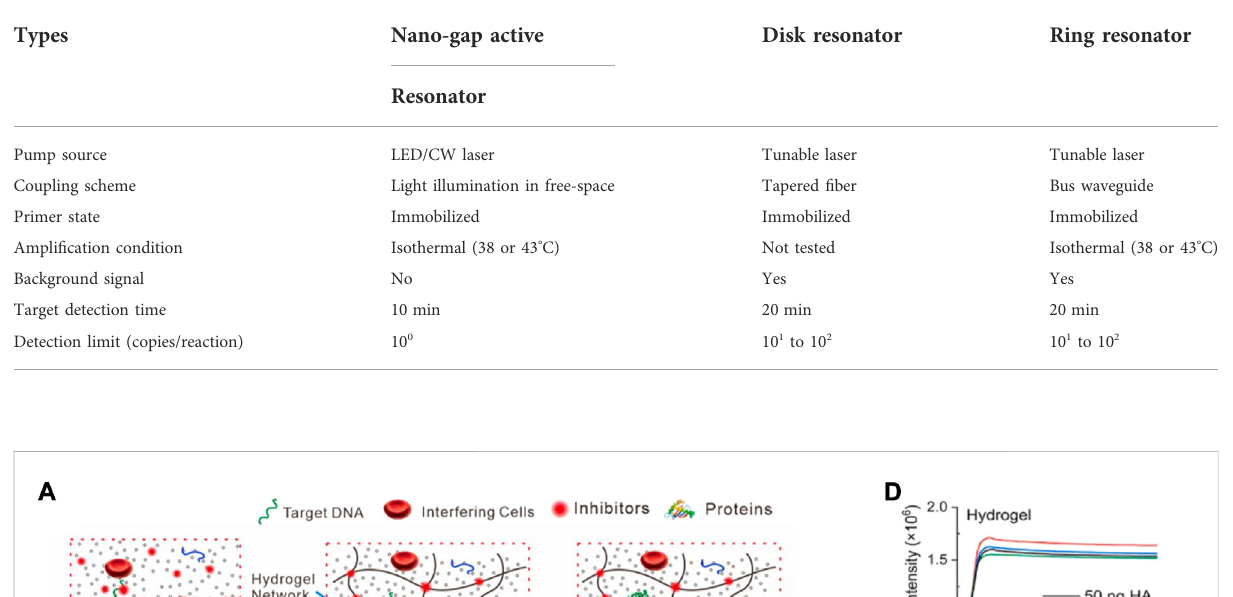
TABLE 1 Comparison of the nano-gap active resonator with other resonators.